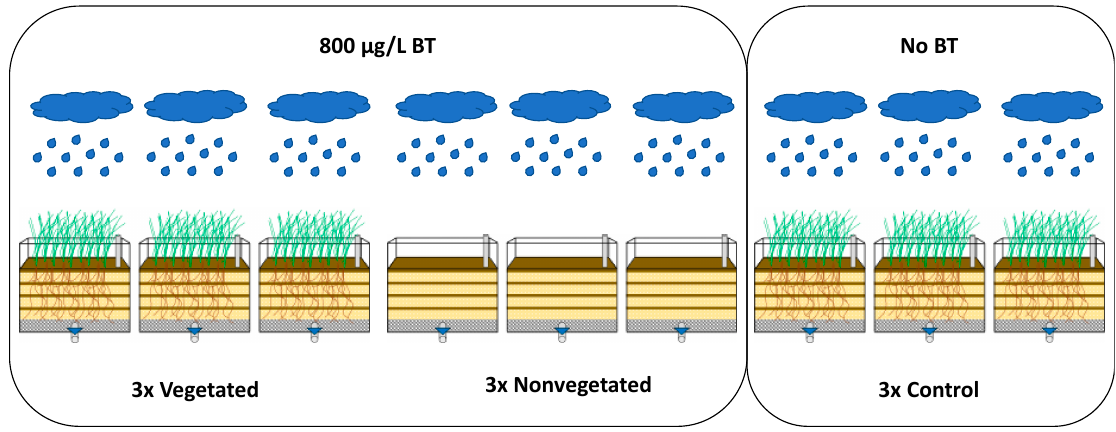
Figure 1. Diagram showing nine total biofilter mesocosms, of which six were planted with C. praegracilis and three were nonvegetated. A monitoring well and an effluent pipe with an outlet control were installed in each mesocosm.